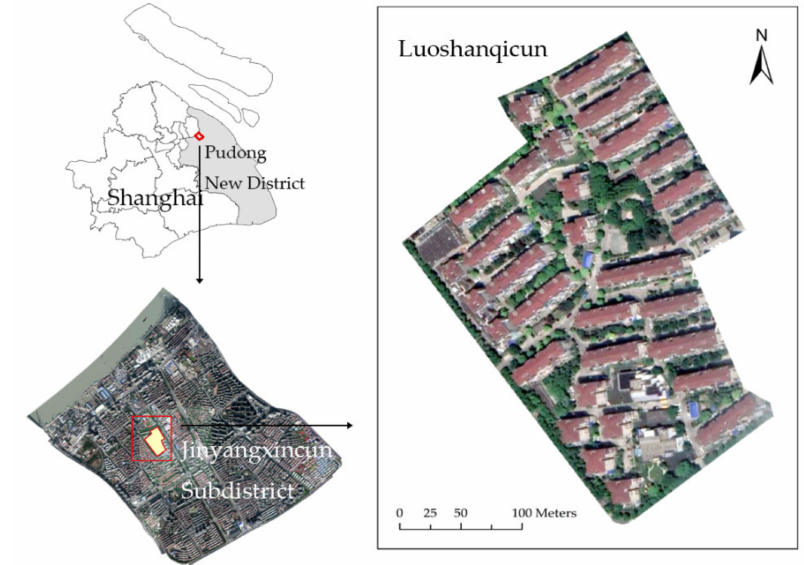
Figure 3. Location of Luoshanqicun Community, Jinyangxincun Subdistrict in Pudong New District, Shanghai,